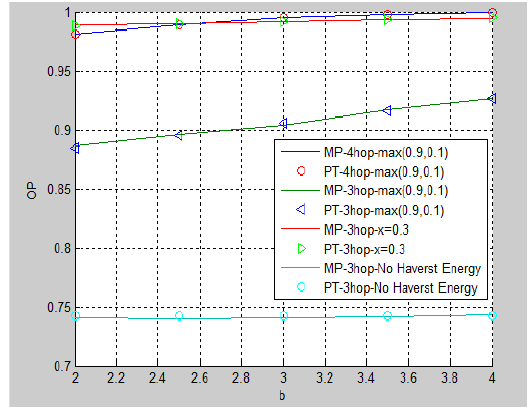
Fig. 8. OP versus I P : K=3, K=4, (x PU , y PU )= (2, 2)